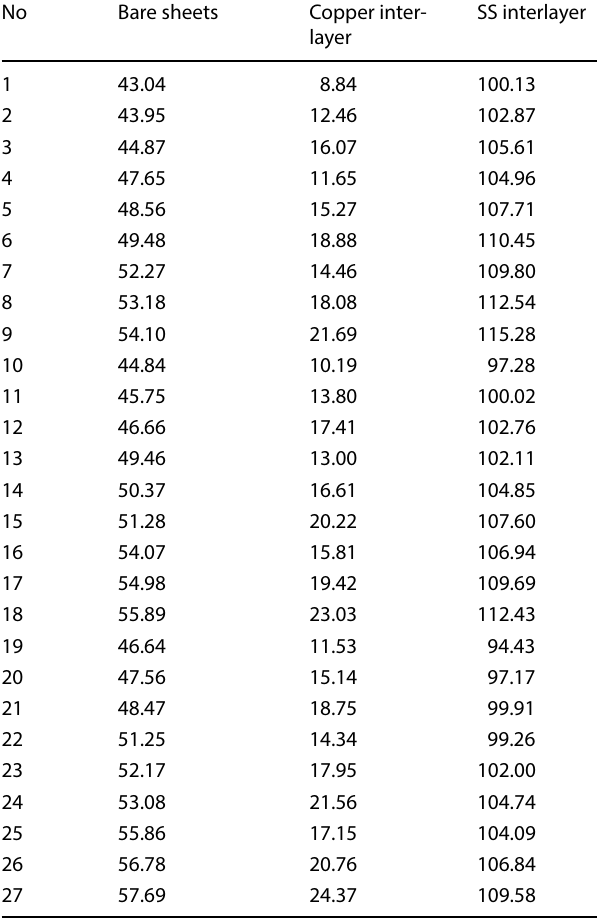
Table 5 LTW Ratio values (kN/Kg)